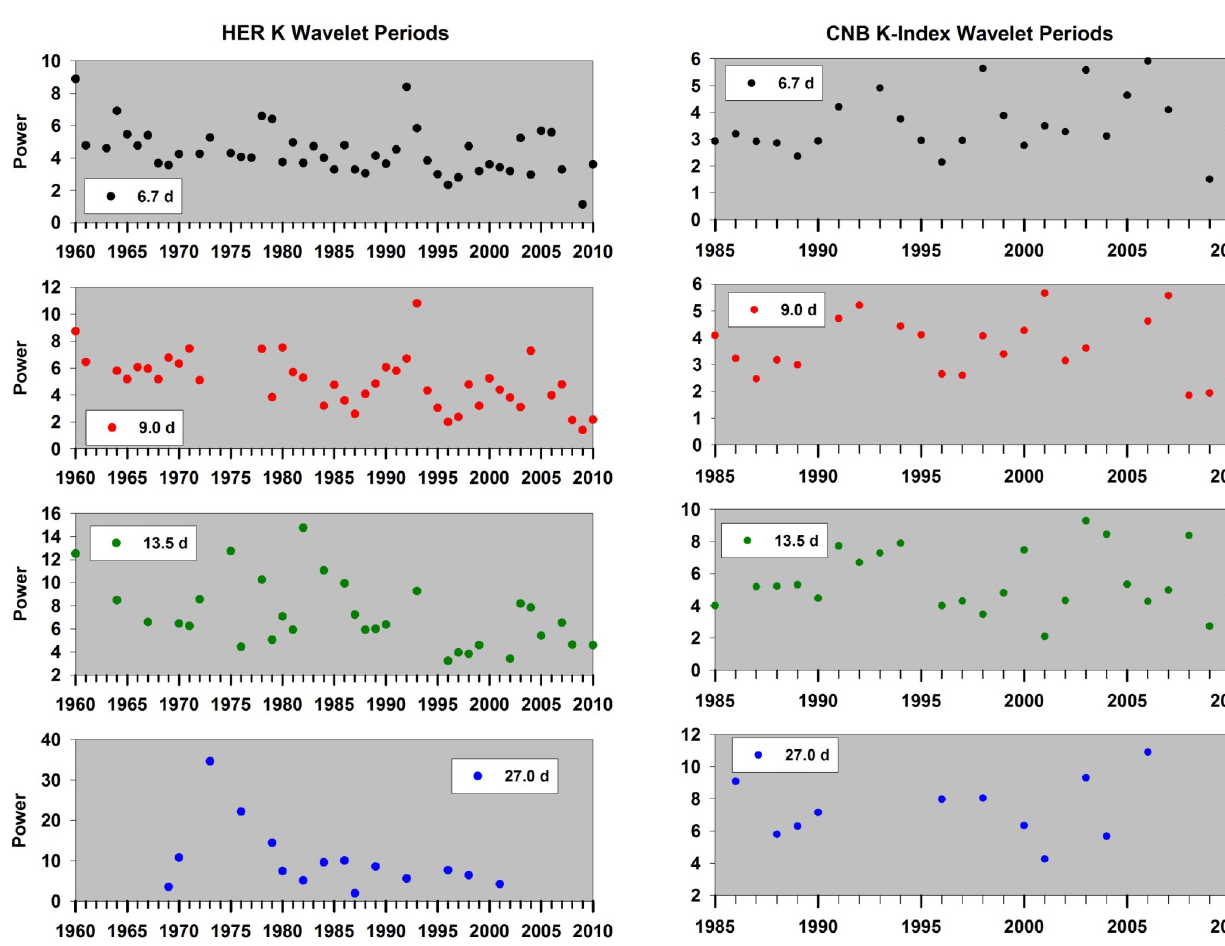
Figure 3. HER recurrence periods as identified in the annual time series of K indices using wavelets from 1960 until 2010.